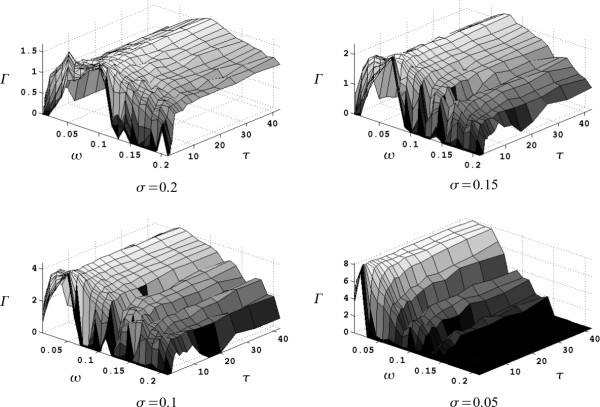
Relative performance Γ for all sets of parameters θ˜ = {σ, ω, τ} evaluated. The viscoelastic constant τ has a negligible effect beyond ~10 tr¯. Furthermore, with lower values of tolerance σ, the set of acceptable parameters {ω, τ} is reduced. However, the relative gain Γ may be significantly larger than that obtained with greater tolerances.